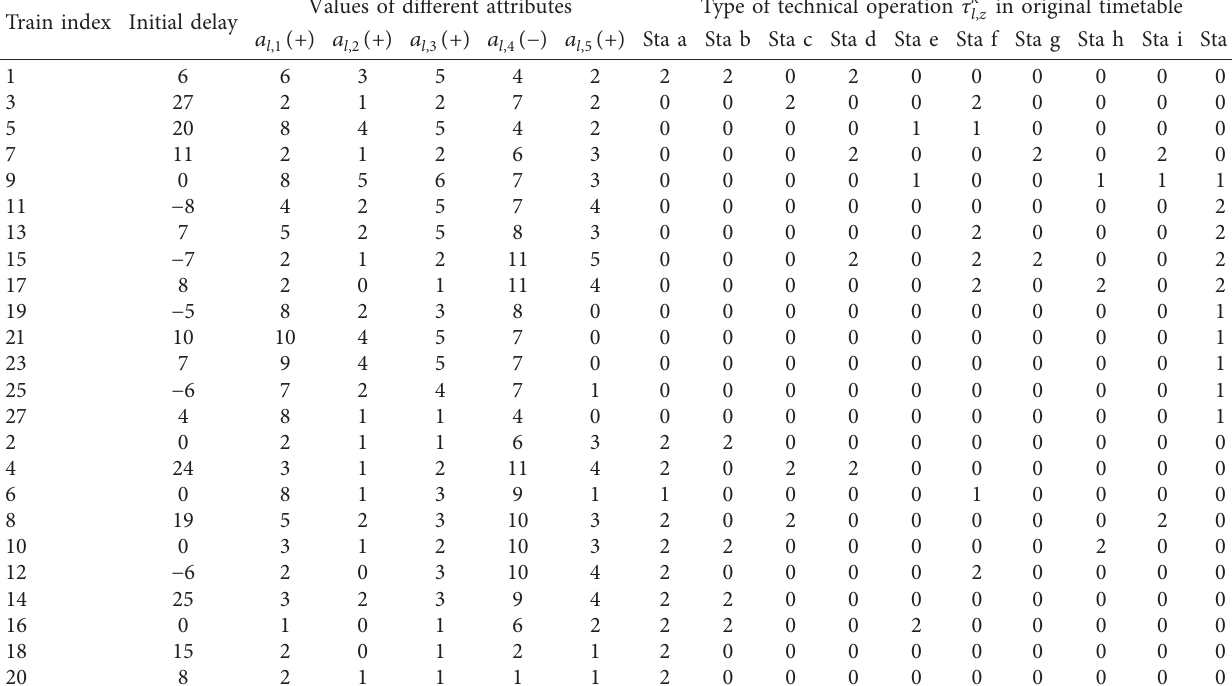
Table 2: Information for each train.